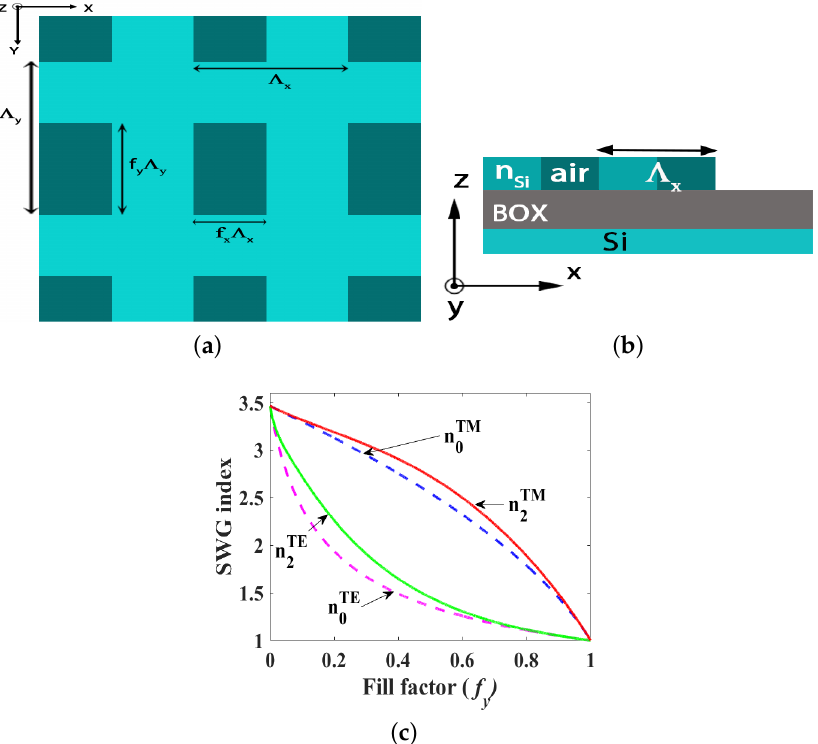
Figure 6. ( a ) A typical subwavelength grating ( SWG ) layout. The subwavelength index is decided by the period width Λ y and the dark blue trench width f y Λ y ( b ) the side view cross-section of an air - Si SWG grating on SOI. ( c ) Variation of SWG index with fill factor of air on a 220 nm thick SOI.